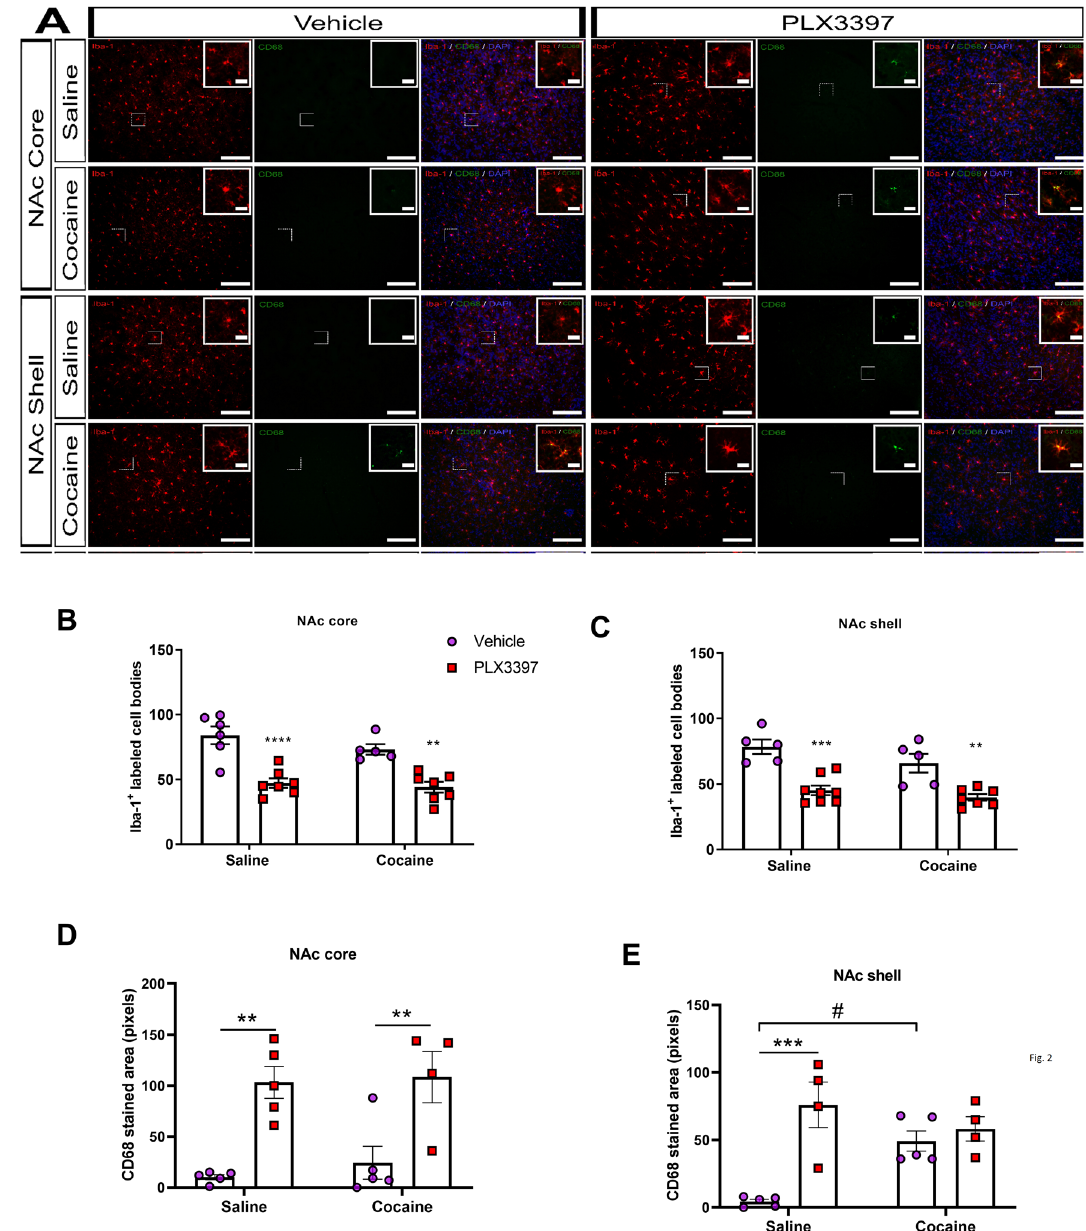
Figure 2. Effects of CSF1R inhibition and cocaine administration on the number of Iba-1 + cells and CD68 + stained area. Representative images of the number and activation of microglia in the NAc core and NAc shell ( A ). Number and activation of microglial cells in the NAc core [cocaine factor (F (1,21) = 2.15; p = 0.1566), CSF1R inhibition factor (F (1,21) = 47.37; p < 0.0001) and cocaine vs CSF1R inhibition factor (F (1,21) = 0.63; p = 0.4358)] and [cocaine factor (F (1,15) = 0.36; p = 0.5540), CSF1R inhibition factor (F (1,15) = 30.92; p < 0.0001) and cocaine vs CSF1R inhibition factor (F (1,15) = 0.07; p < 0.07887)] for Iba-1 + cells and CD68 + stained area, respectively ( B , D ); NAc shell [cocaine factor (F (1,21) = 3.84; p = 0.0633), CSF1R inhibition factor (F (1,21) = 42.44; p < 0.0001)], and cocaine vs CSF1R inhibition factor (F (1,21) = 0.59; p = 0.4480)] and [cocaine factor (F (1,14) = 2.04; p = 0.1750), CSF1R inhibition factor (F (1,14) = 18.14; p = 0.0008) and cocaine vs CSF1R inhibition factor (F (1,14) = 10.91; p = 0.0052)] for Iba-1 + cells and CD68 + stained area, respectively ( C , E ); of animals submitted to the behavioral sensitization. Microscope lens 20 × and 125 µm scale bar for the images, and microscope lens 40 × and 25 µm scale bar for the inserts. Results are expressed as mean ± SEM. #p < 0.05 difference between saline and cocaine groups. **p < 0.01 and ***p < 0.001 compared with the PLX3397 treated group (n = 5–7 in each